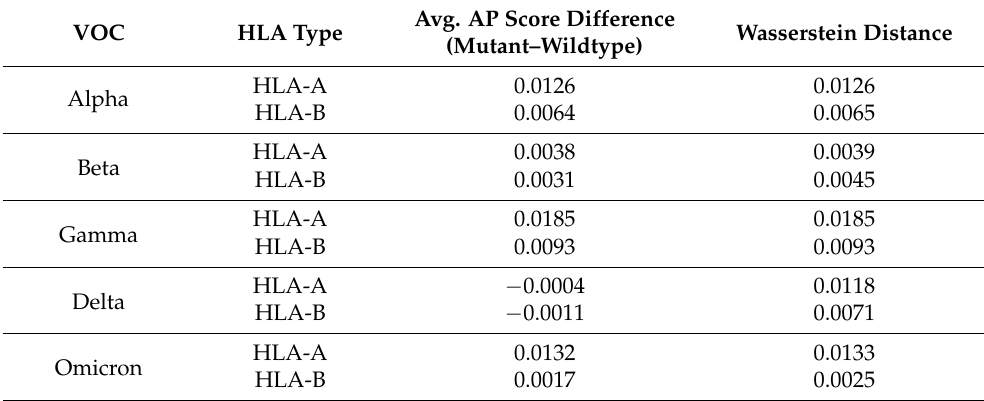
Table 5. Wasserstein distance and average difference between the distribution of AP scores for the mutant and corresponding wildtype peptides for all HLA-A and HLA-B alleles.